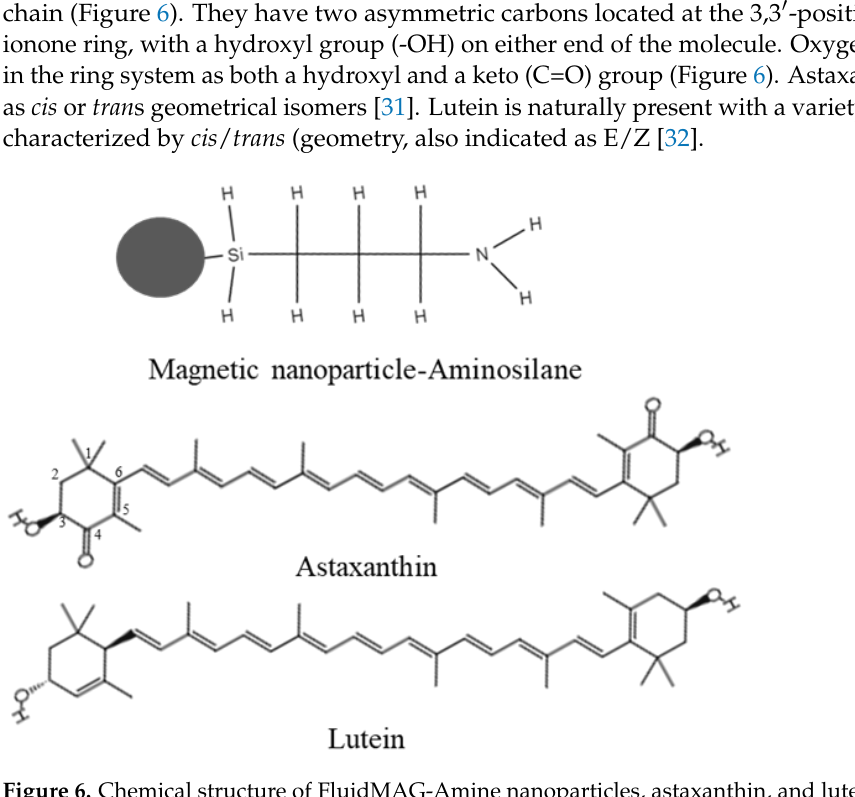
Figure 6. Chemical structure of FluidMAG-Amine nanoparticles, astaxanthin, and lutein.